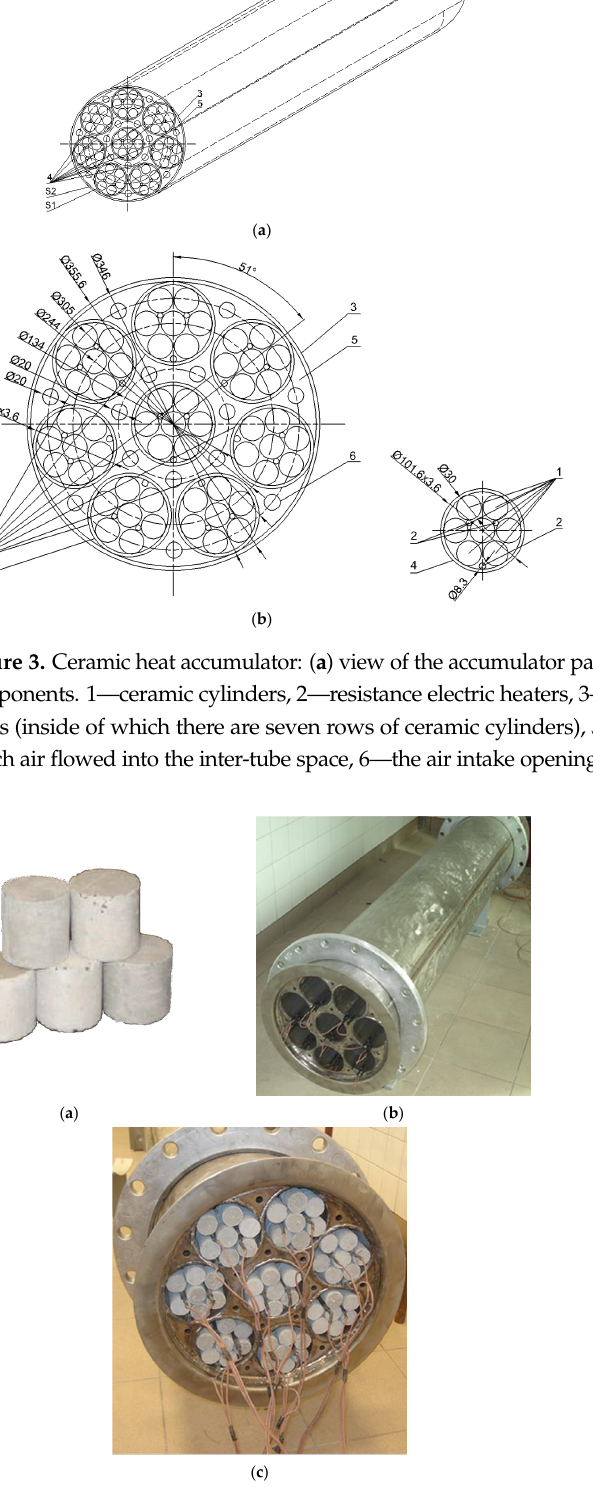
Figure 4. Heat accumulator with dynamic discharge: ( a ) view of cylindrical filling elements; ( b ) external shell of the accumulator with visible steel tubes, inside of which the ceramic cylinders are located; ( c ) front view of the accumulator illustrating the distribution of the ceramic filling elements in the steel tubes with visible connections for resistance heaters. During the day, air flowed through the heat accumulator, which was pre-heated by the accumulator packing. Internal energy stored in the heated packing could be used di- rectly for space heating or via an air – water heat exchanger to heat water in the central heating system.